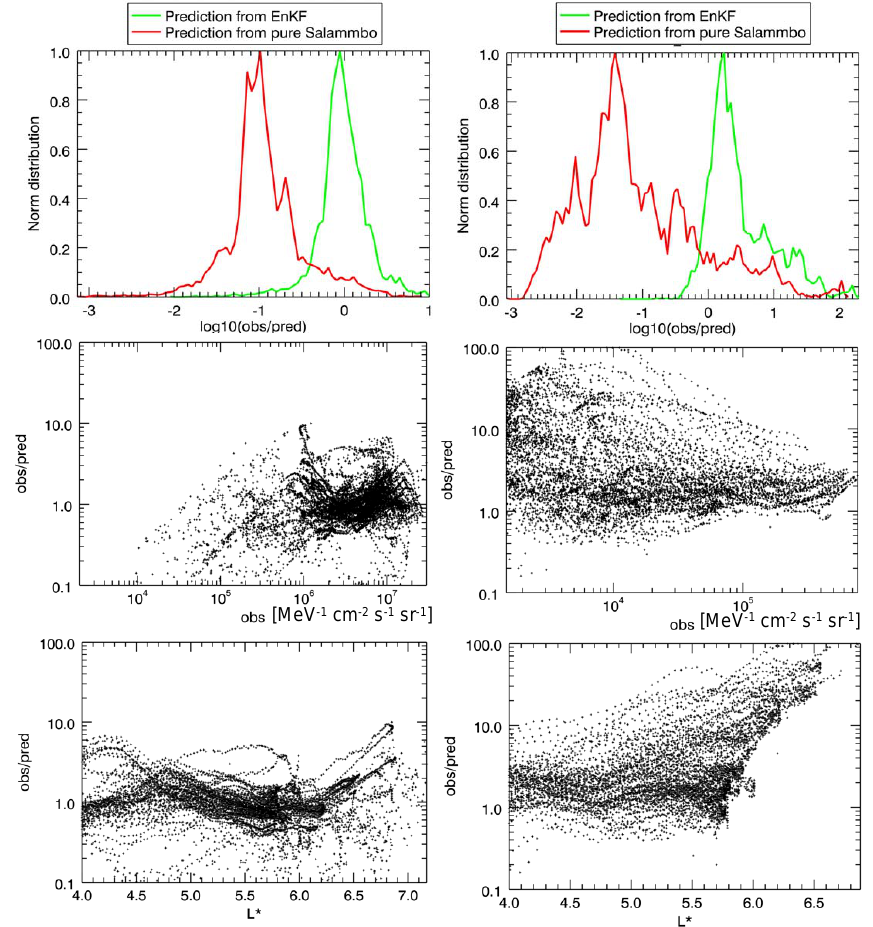
Fig. 13. Error distribution (log (observations/mean predictions)) (top panels), the errors (observations/mean predictions) versus observa- tion values (middle panels) and errors (observations/mean predictions) versus L ∗ (bottom panels), with on the left column electrons with 0.33MeV energy and on the right column electrons with 1.58MeV energy along CRRES